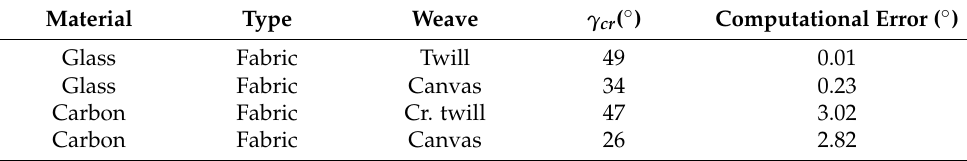
Table 1. Calculated critical shear angles γ cr and comparison to the